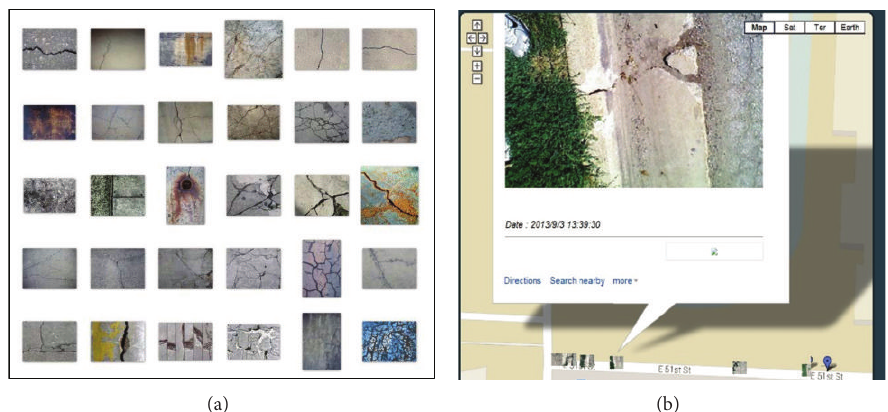
Figure 7: Concrete crack imagery database: (a) a database based Internet searching and (b) a database from field-based imaging using the developed application.